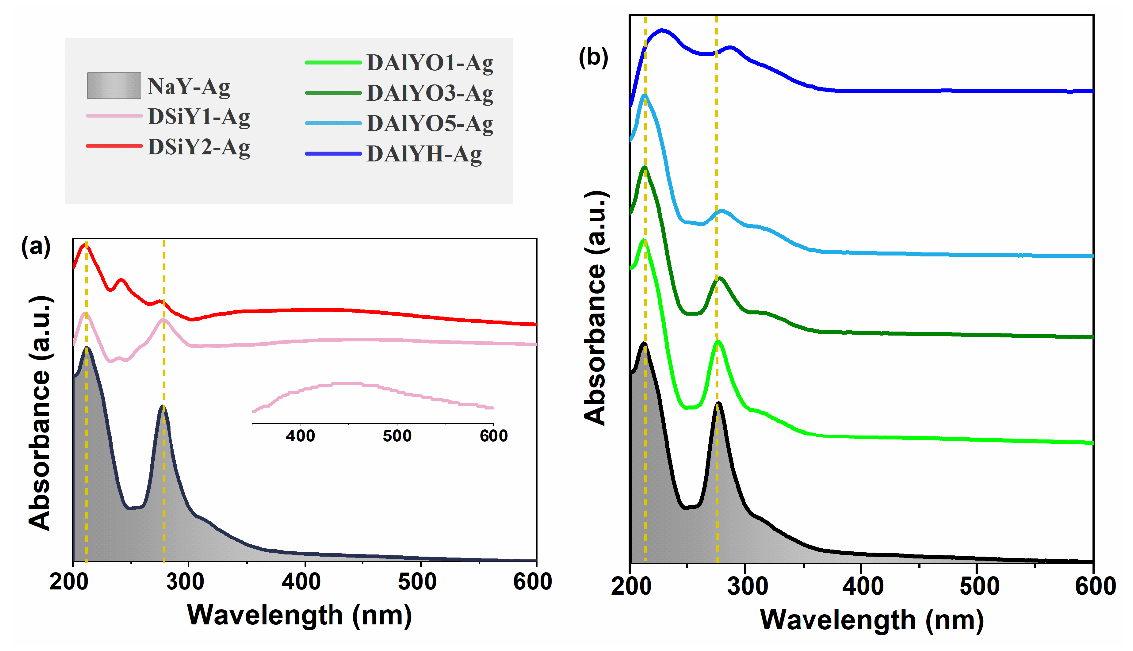
Figure 5. Reflectance spectra plotted in pseudo-absorbance mode for NaY-Ag, DSiY1-Ag, DSiY2-Ag ( a ), NaY-Ag, DAlYO1-Ag, DAlYO3-Ag, DAlYO5-Ag, and DAlYH-Ag ( b ).